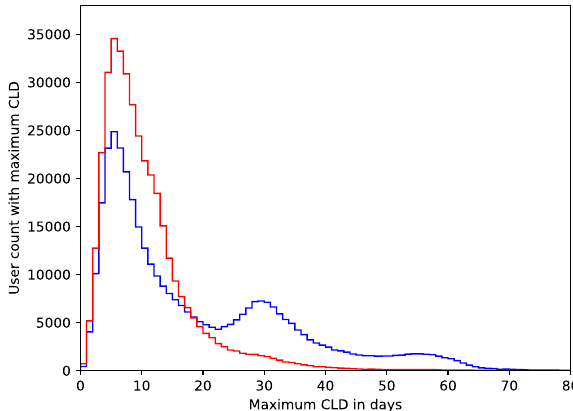
Fig. 8 Histogram of maximum CLD before and after excluding cycle artifacts. For each user, we compute the maximum CLD and plot a histogram before (blue) and after (red) excluding cycles without user engagement (i.e., cycles that are potential artifacts). We see that the multimodal behavior (peaks at around 30 and 60 days) is largely dampened upon removing these cycles. In addition, the fat right-hand tail in the red curve implies that we preserve the natural variation in cycle length — we are not simply removing long cycles.